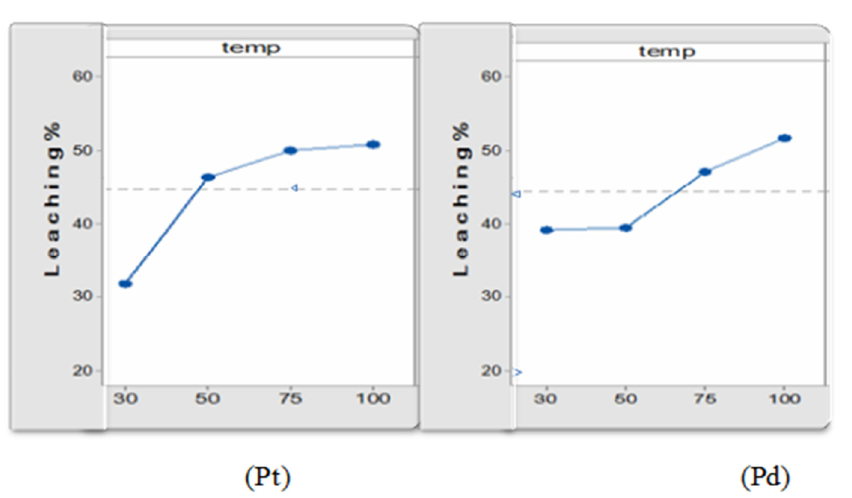
Fig. 5. Efficiency of platinum and palladium leaching by aqua regia solution for each level as a function of temperature.